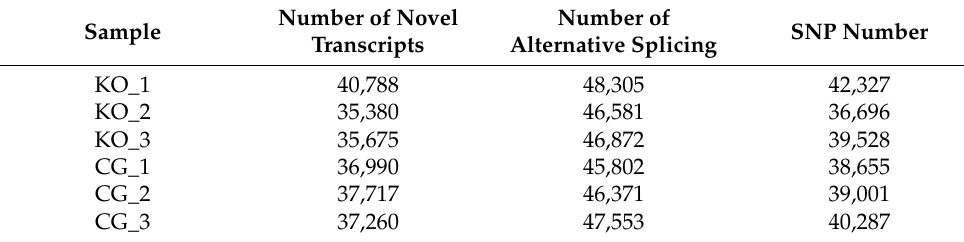
Table 5. Transcriptome